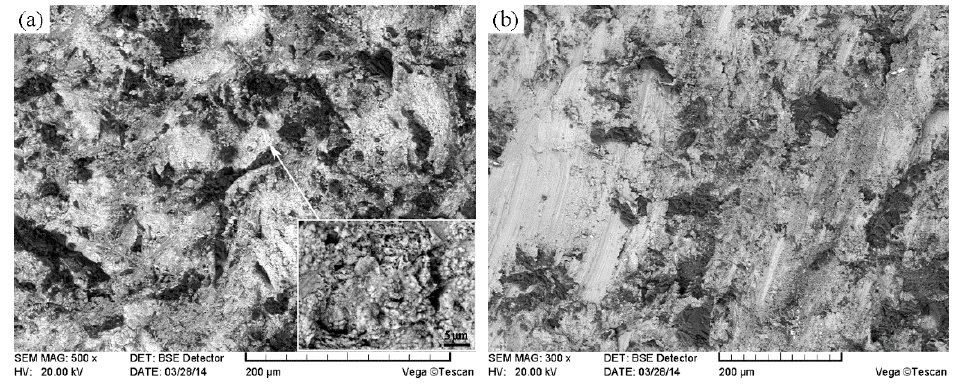
Figure 19. Worn surface morphologies of the modified CTC P -NiCrBSi/heat resistant steel composite layer at 800 °C: ( a ) CTC P -NiCrBSi region, and ( b ) substrate region.